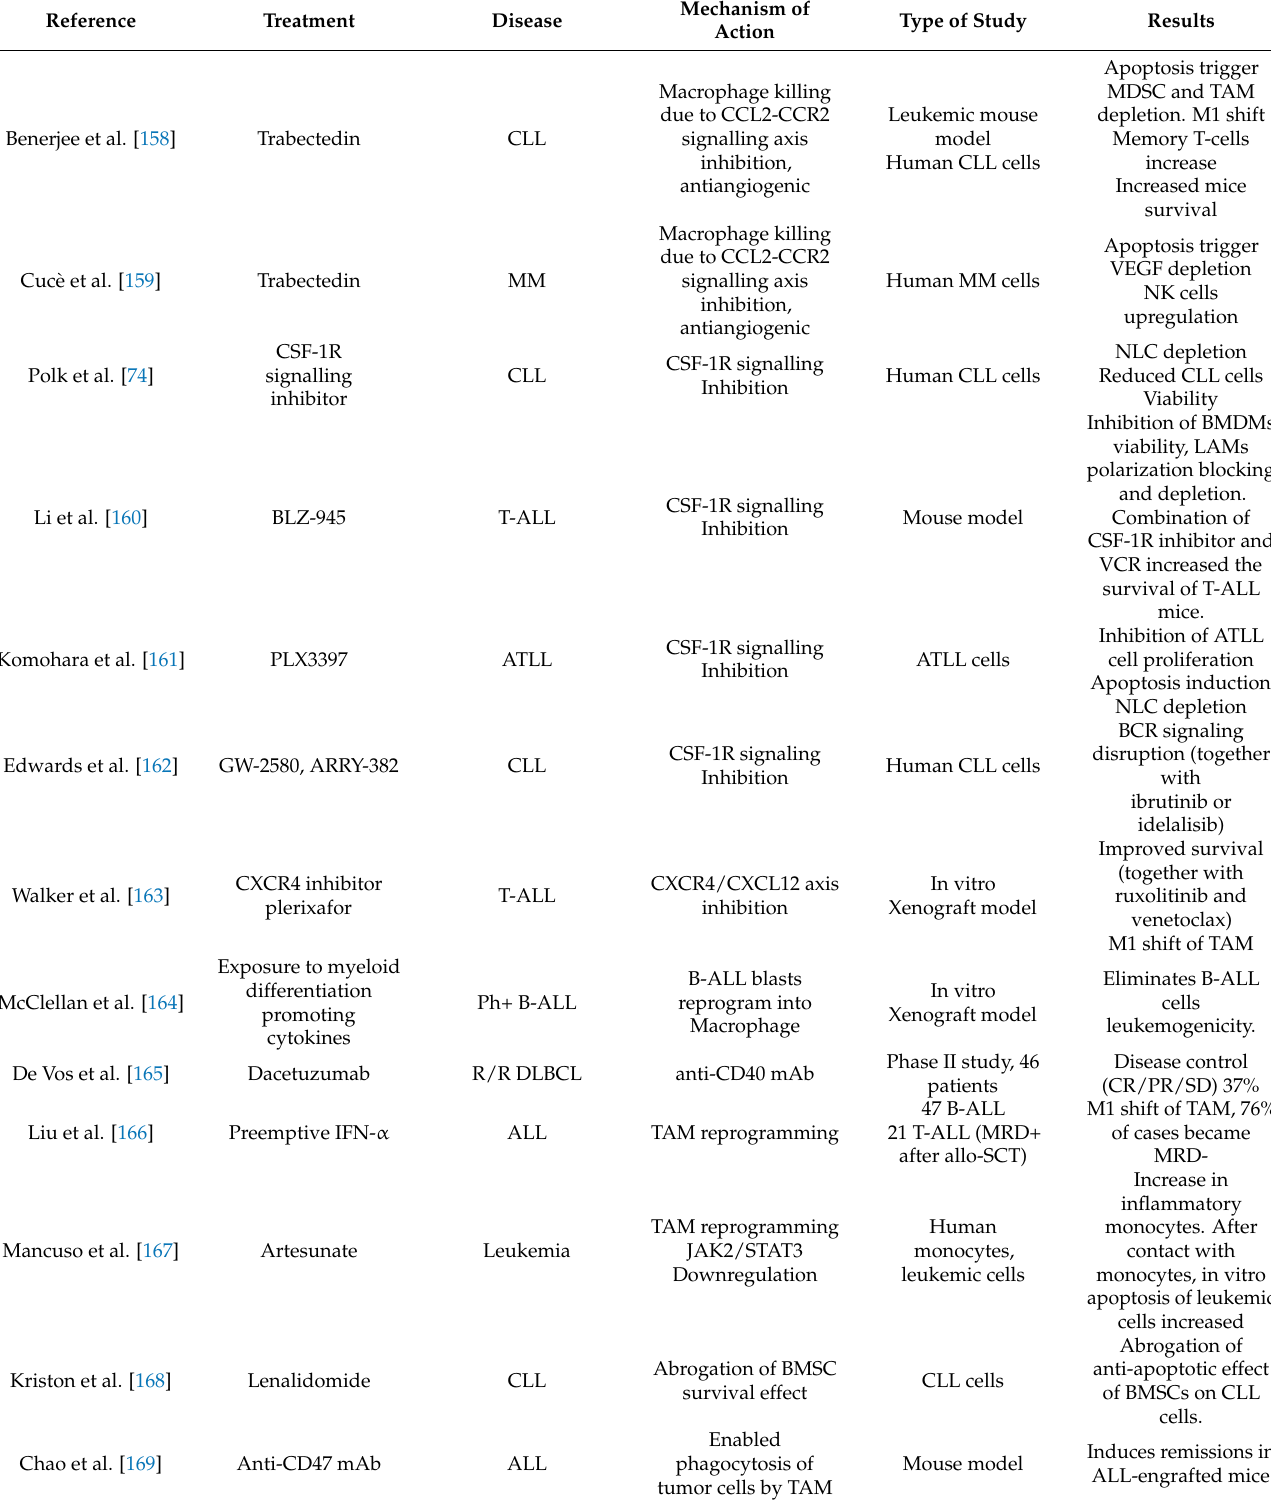
Table 3. The role of tumor-associated macrophages (TAM) as treatment target in hematologic